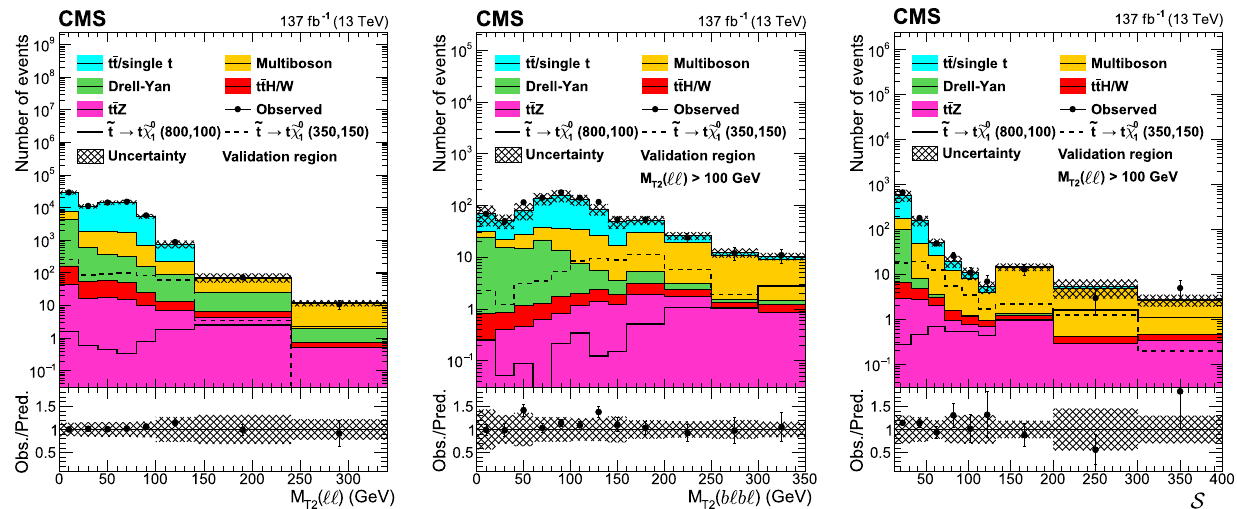
Fig. 3 The M T2 ((cid:5)(cid:5)) , M T2 ( b (cid:5) b (cid:5)) , and S distributions in the valida- tion regions requiring N jets ≥ 2 and N b = 0, combining the SF and DF channels. All other event selection requirements are applied. For the M T2 ( b (cid:5) b (cid:5)) and S distributions, M T2 ((cid:5)(cid:5)) > 100GeV is required. The individual processes are scaled using their measured respective scale factors, as described in the text. The hatched band represents the